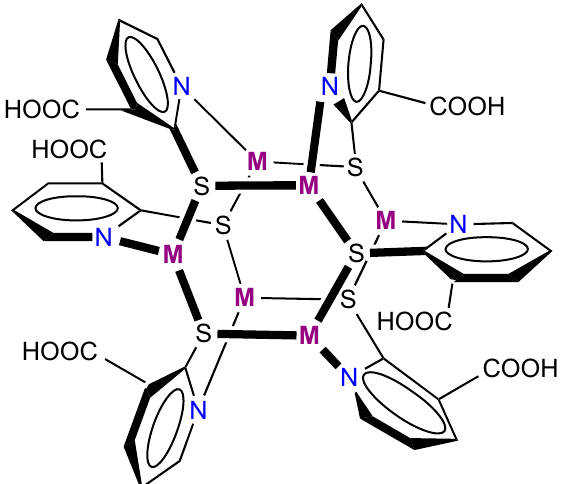
Figure 1. Chemical structures of the [M 6 (Hmna) 6 ] clusters, where M = Cu ( 1 ) and Ag ( 2 ).